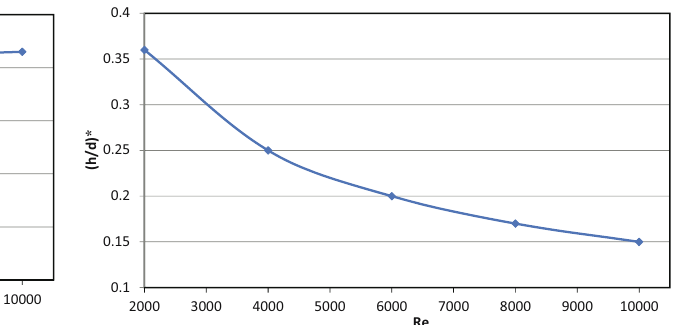
Figure 12: The changes in optimal dimensionless ba ffl e height ( h/d ) * versus Reynolds number.